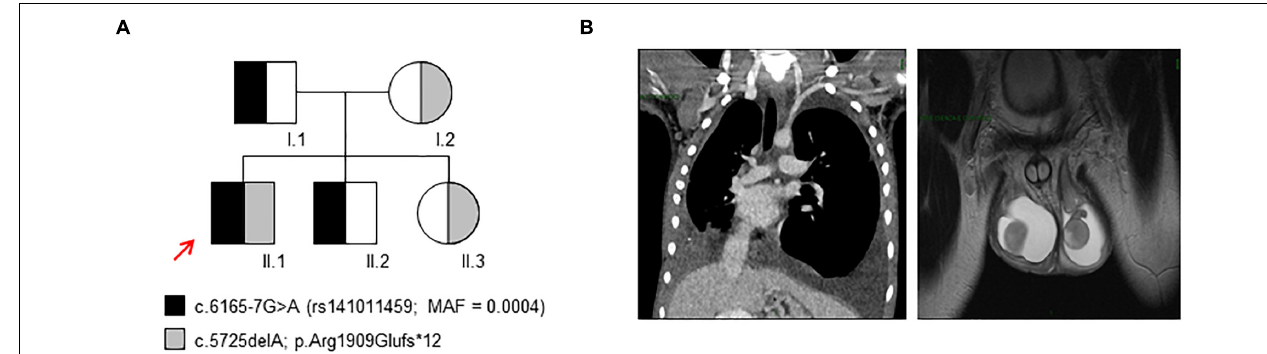
FIGURE 1 | Genetic study and clinical findings. (A) The inheritance pattern of c.6165-7G > A and c.5725delA variants in PIEZO1 in the family here analyzed. The proband (II.1) is a compound heterozygous for these variants. The red arrow indicates the proband. (B) Magnetic resonance image of the proband (II.1) showing chylothoraces and